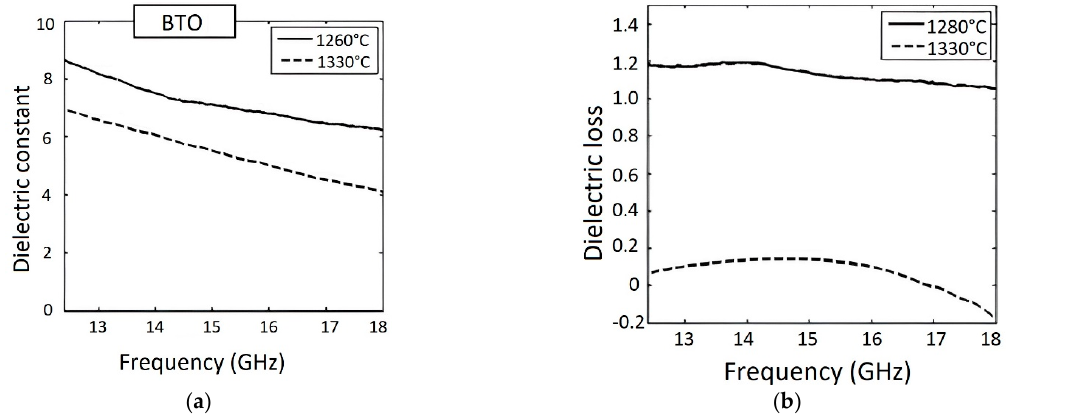
Figure 18. ( a ) Dielectric constant and ( b ) Dielectric loss for BT sintered at 1260 and 1330 °C for a frequency range of 12.4–18 GHz (Reprinted from Ref. [99], copyright (2015), with the kind permission of Elsevier Ltd. and Techna Group S.r.l.).